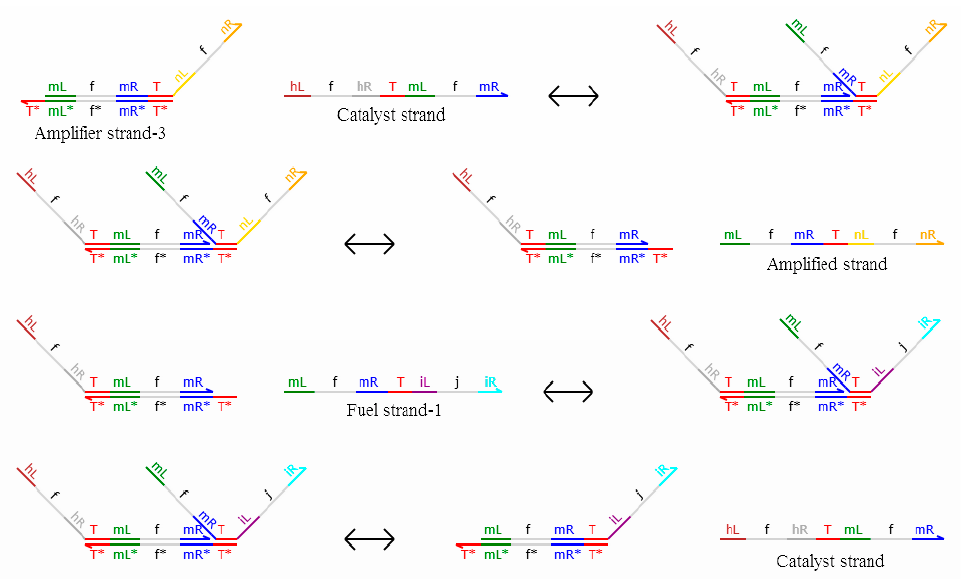
Figure 6. Reaction between fuel strand-1and amplifier strand-3.